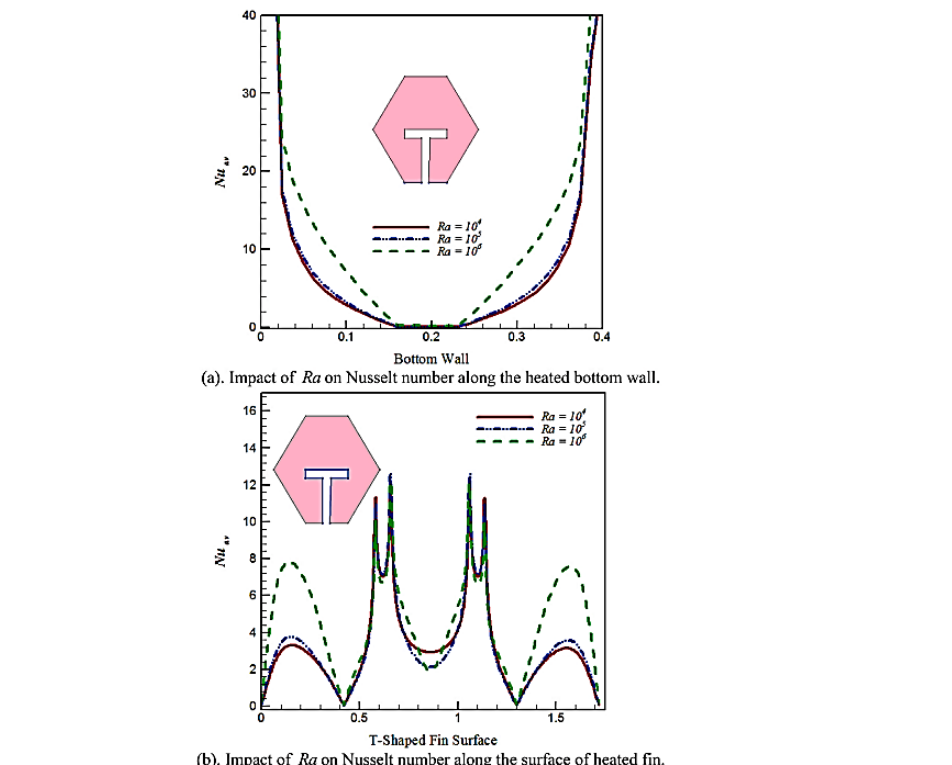
Haq et al. (2020) [38] provided a numerical investigation of the lid-driven hexagon hollow filled with water. The top wall of the hollow is partly heated and flowing at a uniform velocity. Furthermore, a cylindrical barrier is placed within a hexagonal hollow, imposing various constraints on the surface. The simulation is run to estimate the heat transfer rate, steam lines, and isotherm behavior as a function of the physical and geometrical factors included in the model, including Reynolds number, Richards number, Hartman number, and heated length. As shown in Figure 17, the circular obstacle played an important part in the development of isotherms by changing the different constraints at the